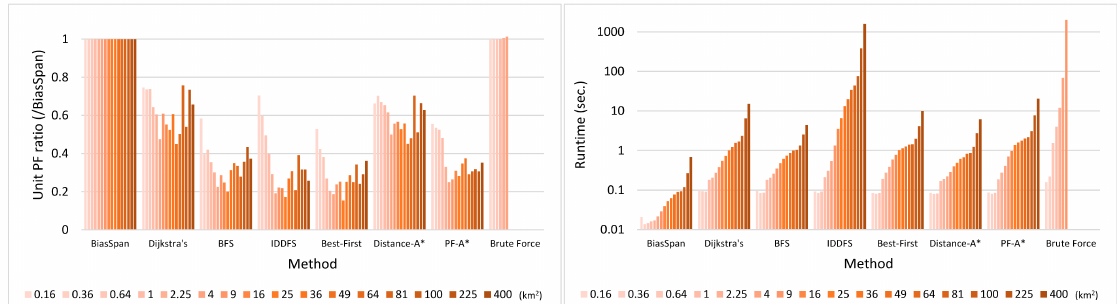
Figure 9. Unit PF ratio ( left ) and runtime ( right ) for different methods under area range in Chicago dataset. For methods with more than half failure cases, their performance would not be